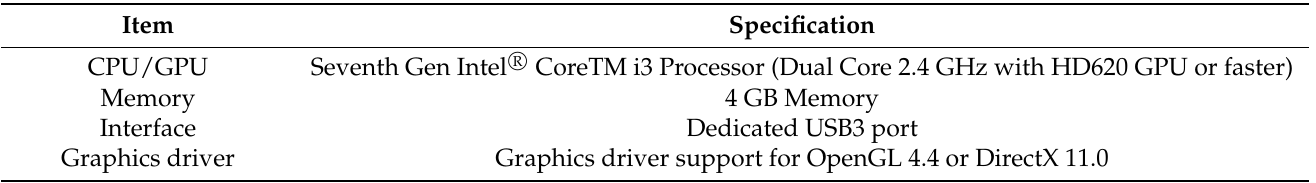
Table 6. Minimum host PC hardware requirements.